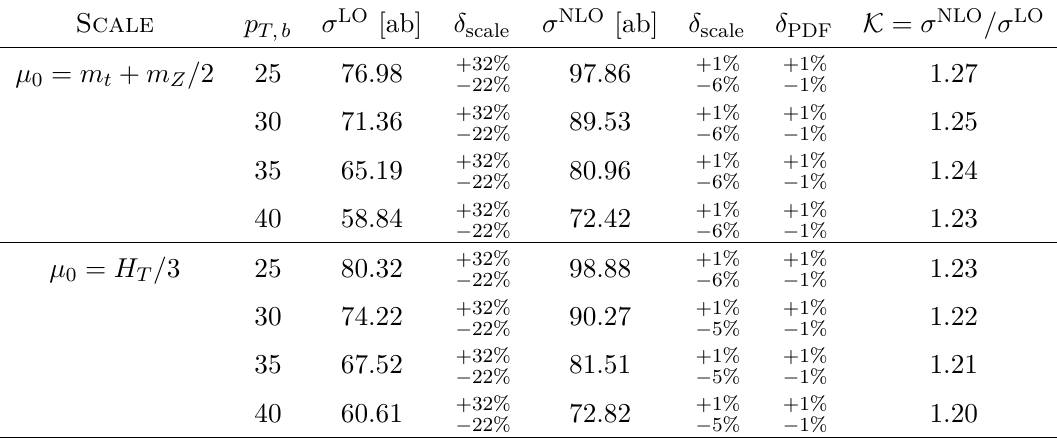
Table 4 . LO and NLO integrated fiducial cross sections for the pp → e + ν e µ − ¯ ν µ b ¯ b τ + τ − + X process √ at the LHC with s = 13 TeV. Results are evaluated using µ R = µ F = µ 0 where µ 0 = H T / 3 and µ 0 = m t + m Z / 2 . The LO and NLO NNPDF3.1 PDF sets are used. We display results for four different values of the p T,b cut. Also given are the theoretical uncertainties coming from scale variation ( δ scale ) and PDFs ( δ PDF ) . In the last column the K -factor is shown. Monte Carlo errors are at the permille or sub-permille level.